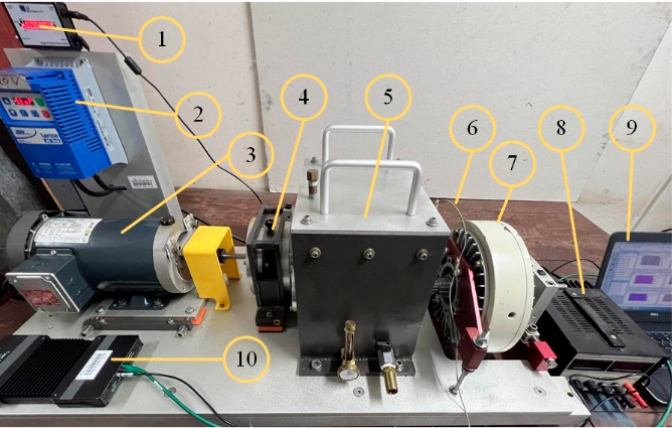
Figure 5. Specific arrangement of DDS. 1. Speedometer. 2. Converter. 3. Drive motor. 4. Planetary gearbox. 5. Parallel gearbox. 6. Accelerometer. 7. Load. 8. Load controller. 9. Laptop. 10. Acquisition